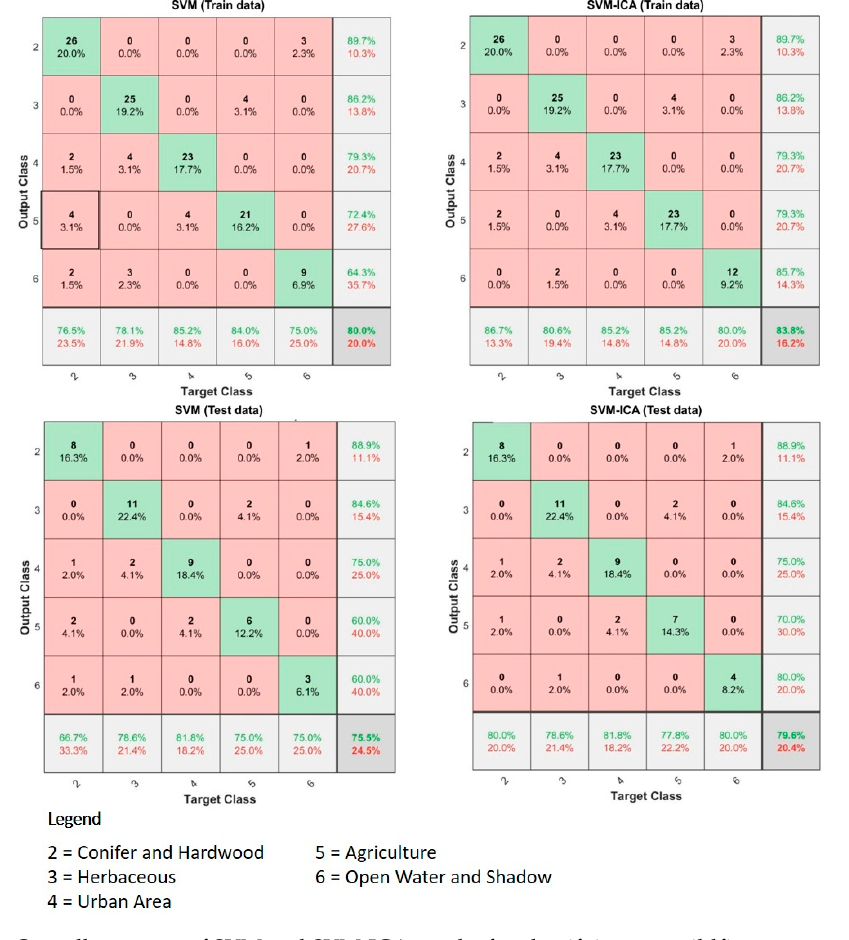
Figure 8. Overall accuracy of SVM and SVM-ICA results for classifying pre-wildfire occurrence from the Landsat-8 images.